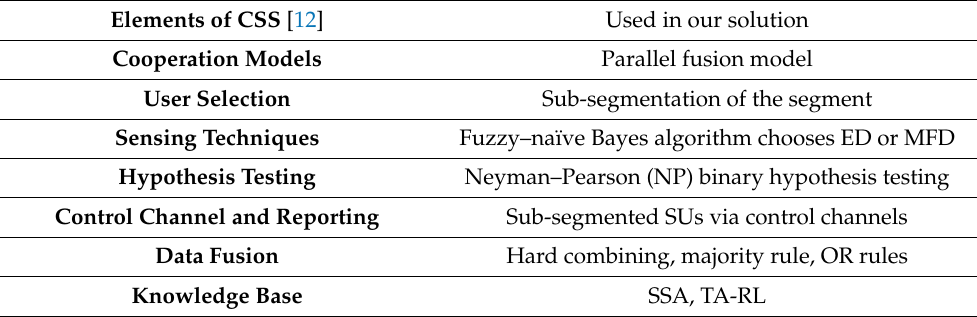
Table 3. Elements of proposed